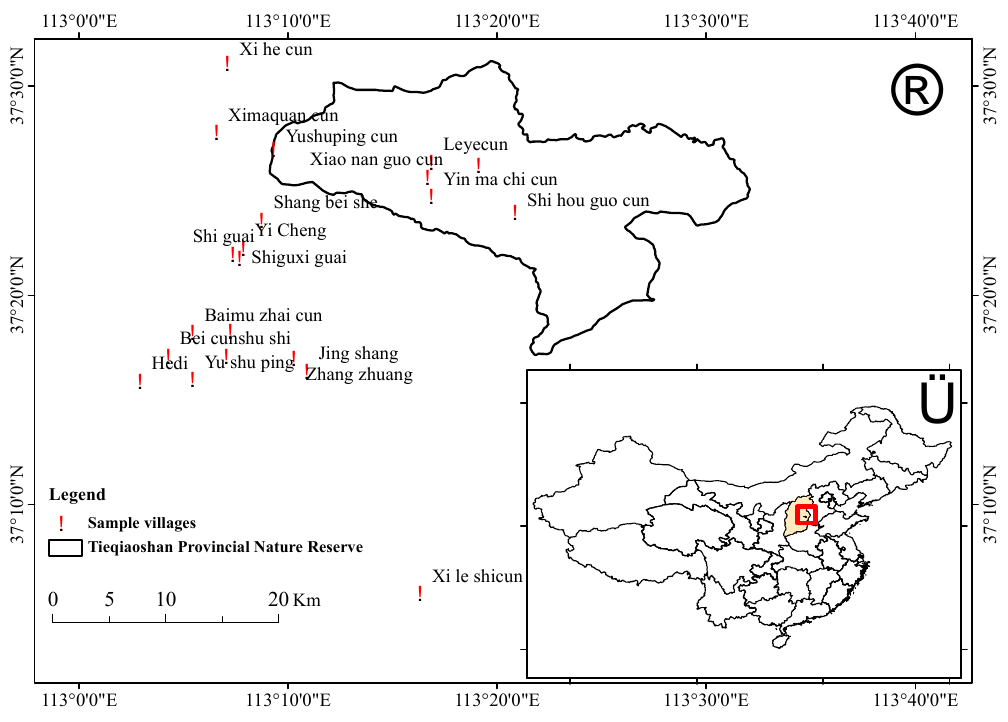
Figure 1. Map showing study area.